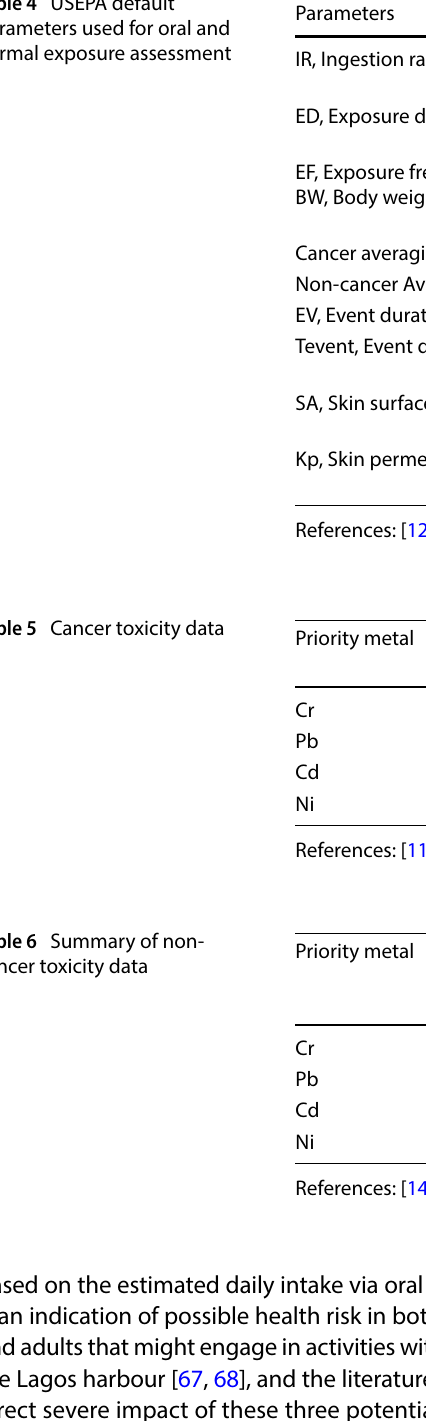
Table 4 USEPA default parameters used for oral and dermal exposure assessment